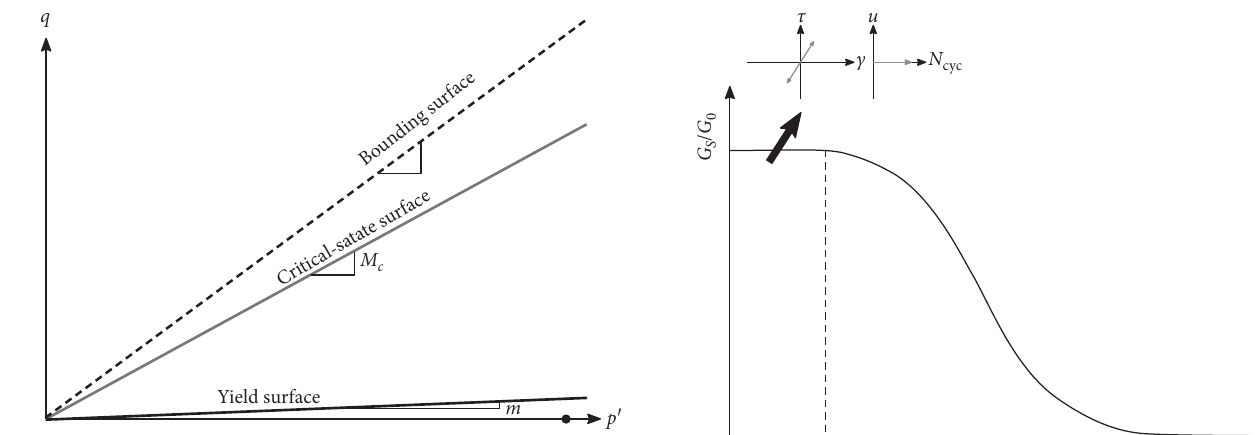
Figure 1: Bounding, critical-state, and yield surfaces for iso- tropically consolidated sand samples in the p’ -q plane used in the bounding surface models [1, 2, 5]. Figure 2: Typical degradation curve of secant shear modulus G s to cyclic shear strain c and definition of the linear elastic threshold strain c tl during undrained cyclic